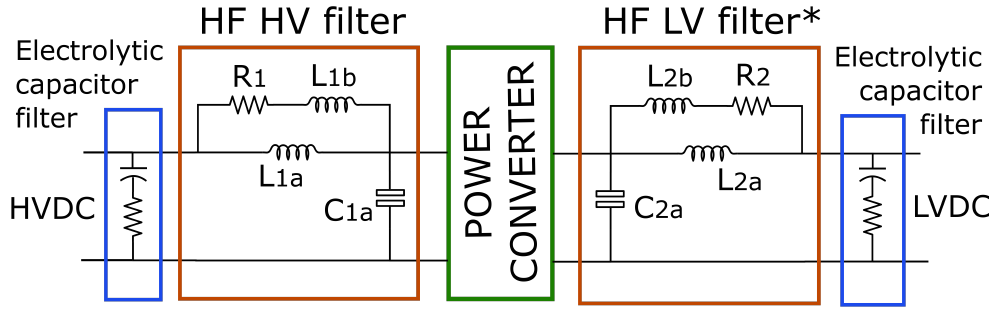
Figure 3. Complete converters filter structure. * HF LV filter block is not required in ABAC and CD